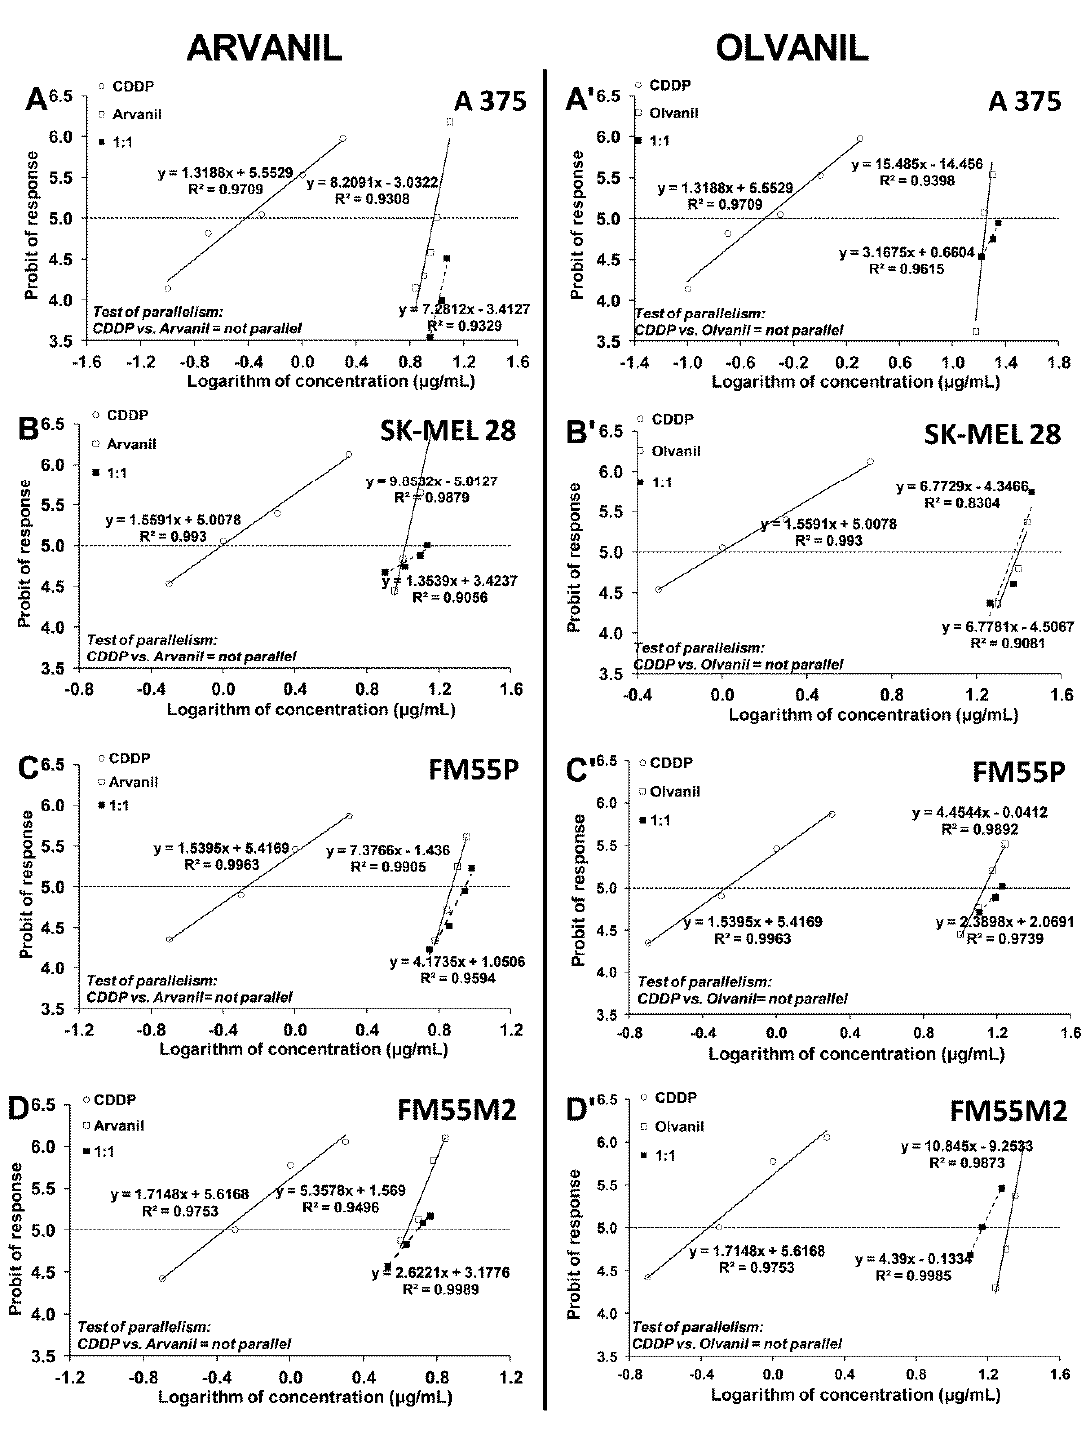
Figure 8. Concentration–effect lines for arvanil, olvanil, and CDDP administered alone and in combination in the fixed-ratio of 1:1, illustrating the anti-proliferative effects of the drugs in the malignant melanoma cell lines: A375 ( A , A’ ), SK–MEL 28 ( B , B’ ), FM55P ( C , C’ ), and FM55M2 ( D , D’ ) measured in vitro by the MTT assay. Test for parallelism confirmed that the experimentally determined concentration–effect lines for arvanil, olvanil, and CDDP (administered alone) are mutually non-parallel to each other in A375, SK–MEL 28, FM55P, and FM55M2 cell lines.